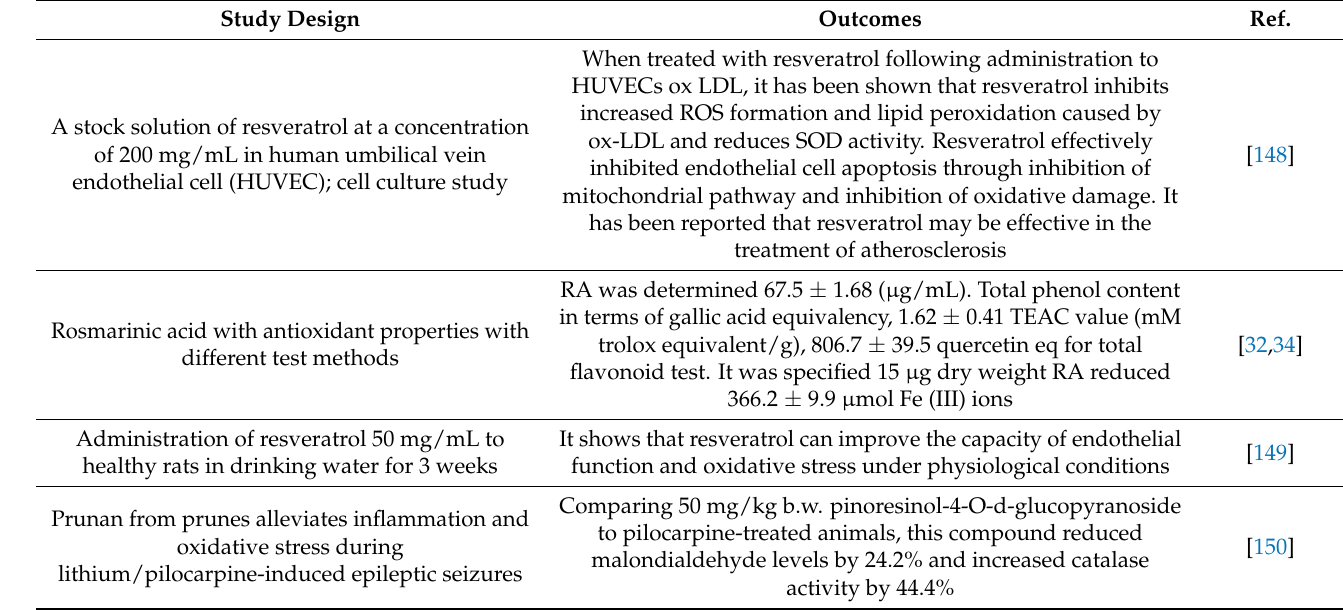
Table 3. Some of the information regarding polyphenols efficacies, working concentration, and target of each substance on ROS-induced oxidative